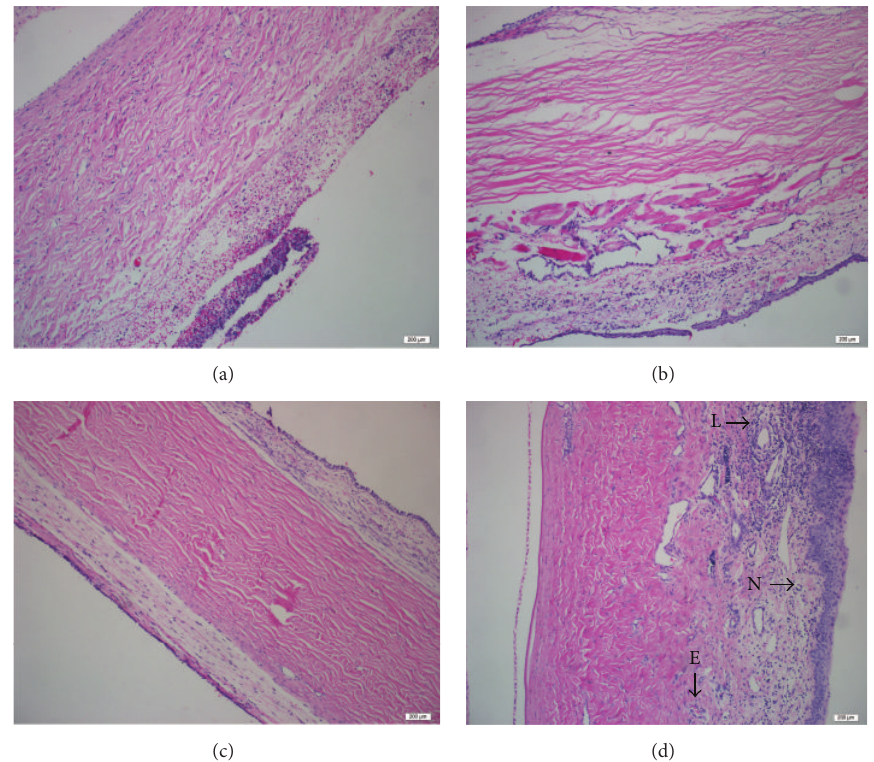
Figure 5: Comparison of the staining intensity of H&E. (a) Severe inflammatory reaction on the 1st day in PRF membrane specimens ( × 200). (b) Mild inflammation seen on the 1st day in the control group ( × 200). (c) Conjunctival tissue formation with normal histomorphology seen on day 28 in the PRF membrane group ( × 200). (d) Mixed cellular inflammation contains neutrophil leucocytes (N), lymphocytes (L), and eosinophils (E) seen on day 28 in the control group ( × 200).